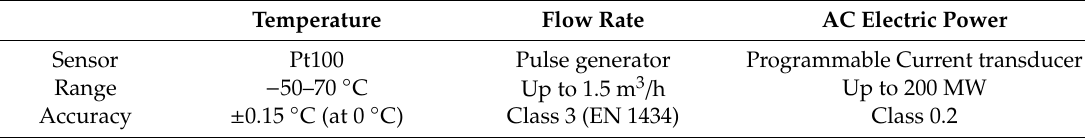
Table 2. Main features of the sensors employed in the monitored air-conditioning